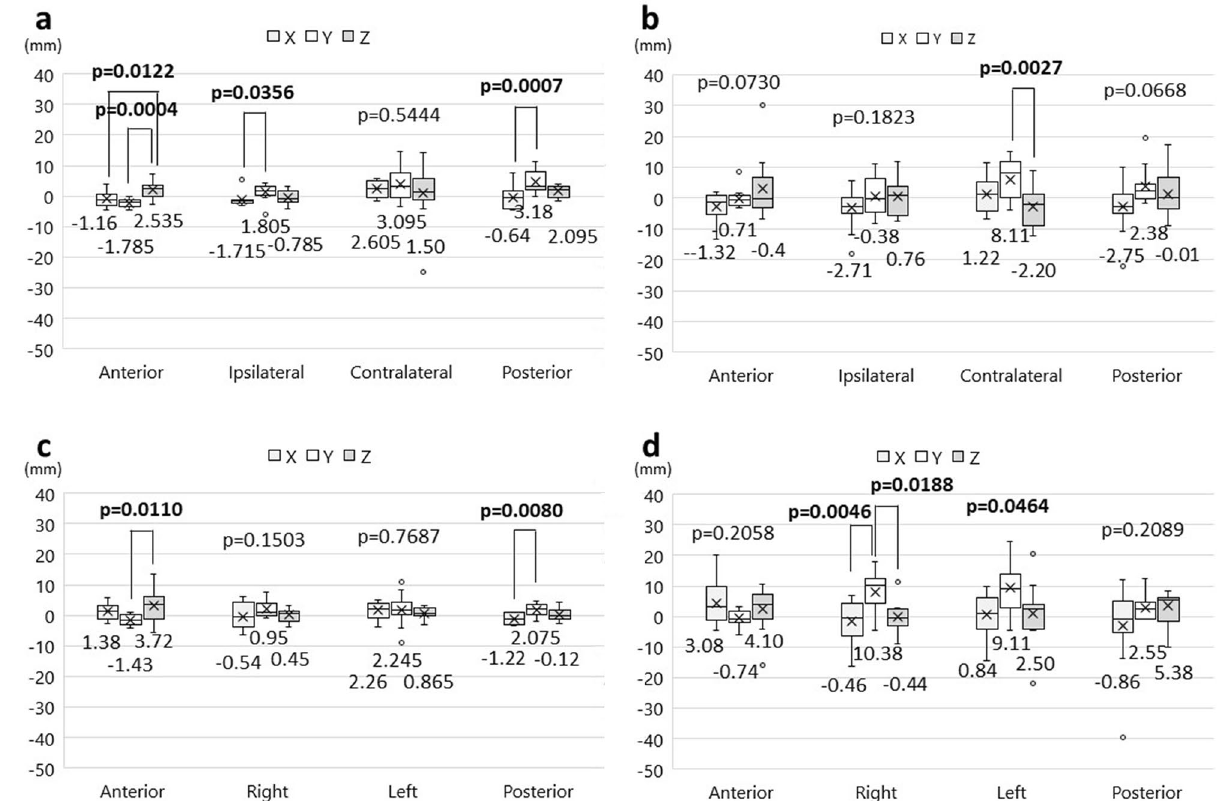
Figure 6. The direction of the distance errors for each fiducial marker in the lateral and prone positions. Box plots show the values of the distance errors in the xyz-components of each marker. ( a ), automatic intraoperative registration in the lateral position; ( b ) surface-merge registration in the lateral position; ( c ) automatic intraoperative registration in the prone position; ( d ) surface-merge registration in the prone